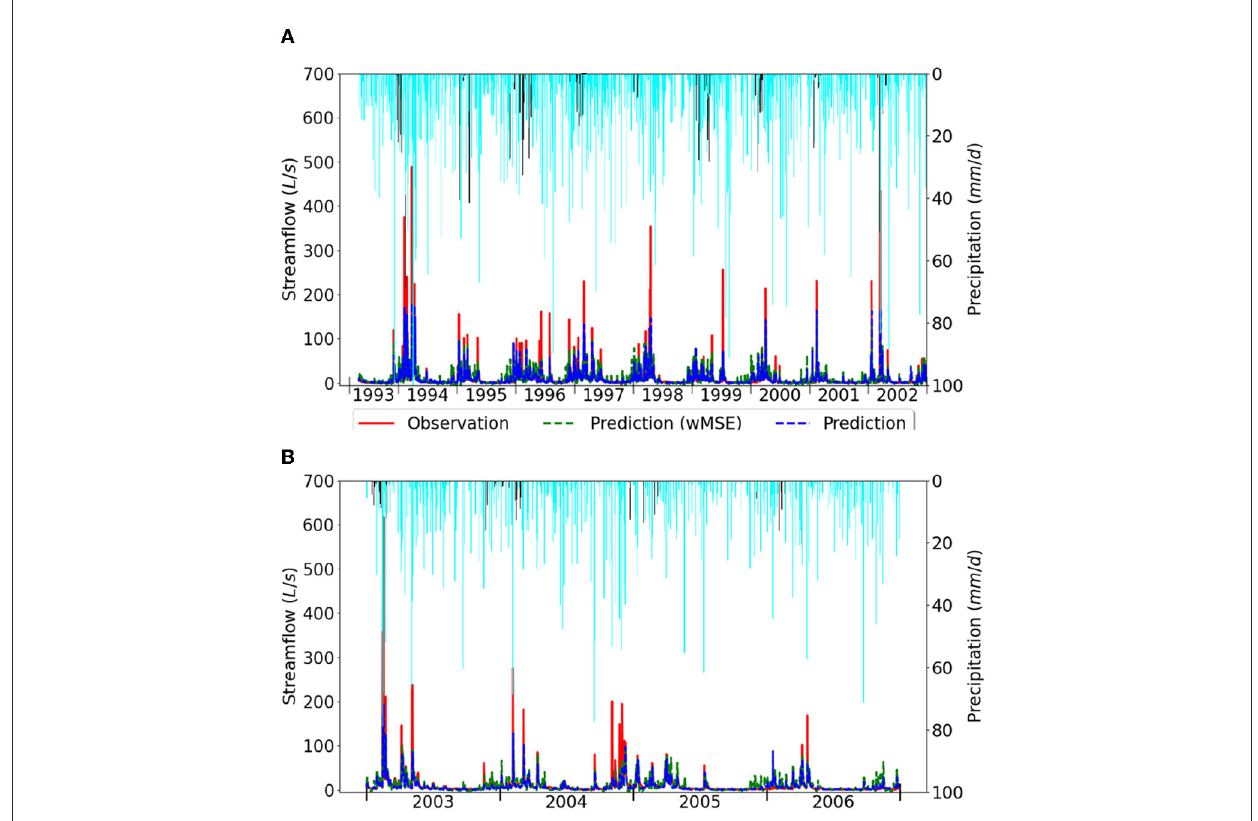
FIGURE9 Predicted (dashed blue line) and observed streamflow (solid red line) in the East Fork of rain-driven WBW. Also shown in green lines are LSTM predictions using weighted mean squared errors as the loss function. Corresponding daily precipitation is plotted upside down on the top associated with the right y-axis, where snow (temperature below 0 ◦ C) is highlighted in black. (A) Training data of 1993–2002. (B) Test data of 2003–2006.